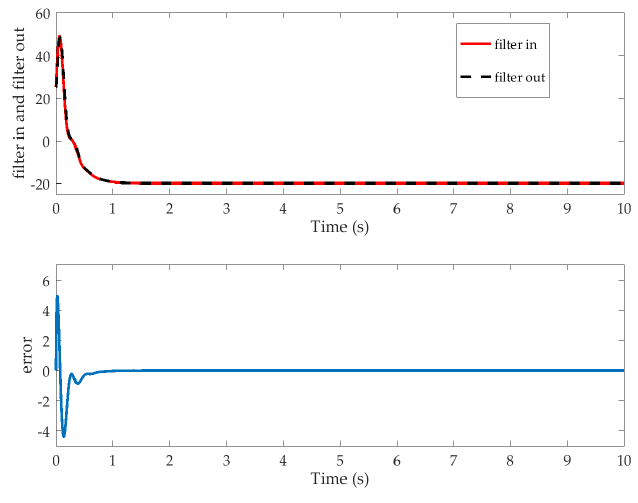
Figure 12. Time response of the first-order